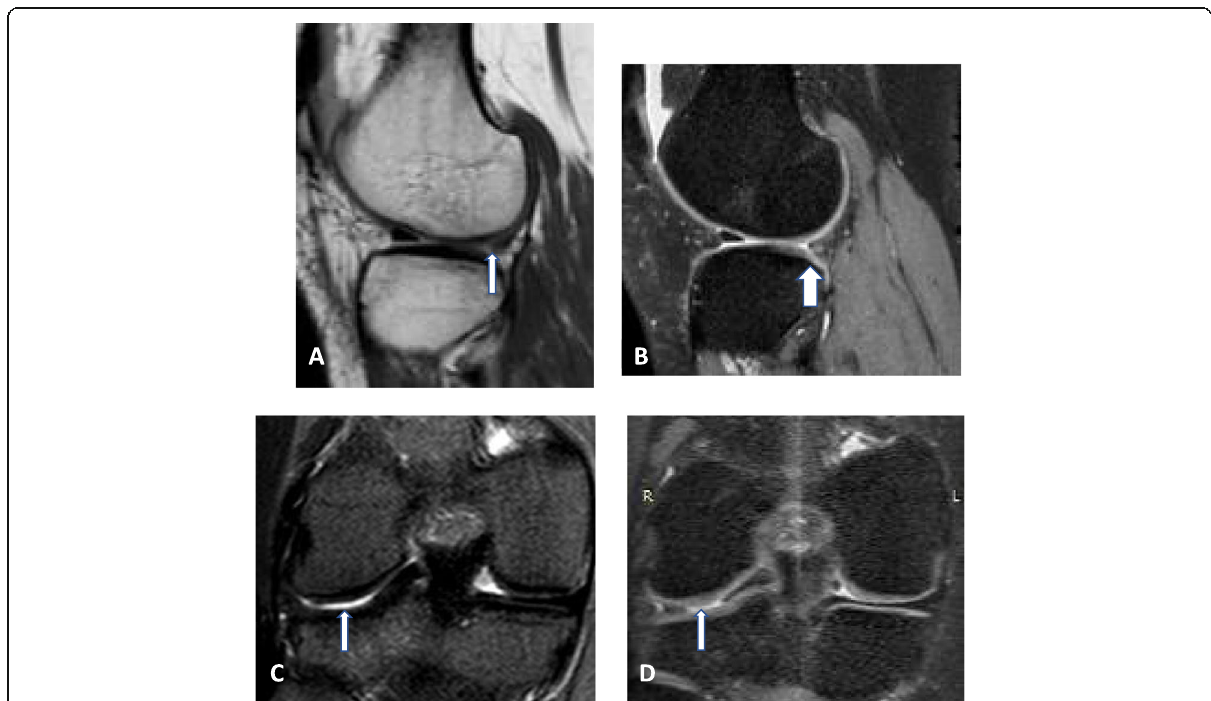
Fig. 2 A 27-year-old male patient presented by acute RT knee joint pain after trauma. a , b Sagittal standard 2D PDWI and 3D MPR VISTA. c , d